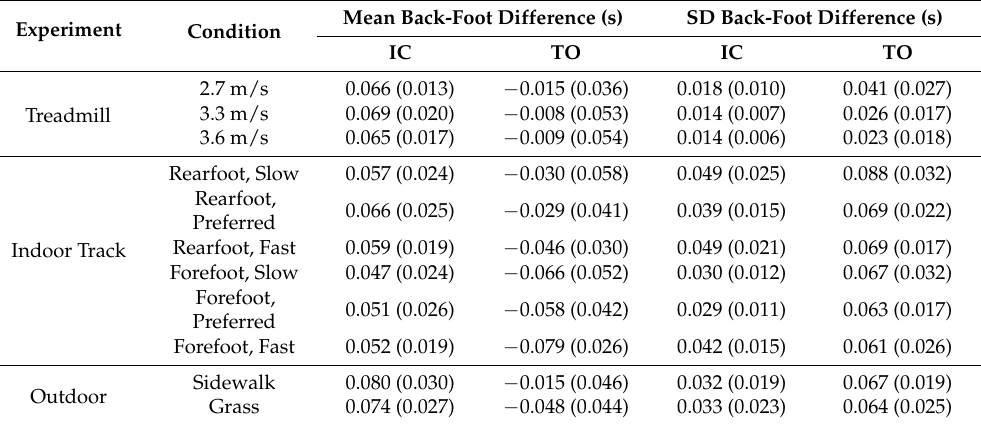
Table 1. The mean and standard deviation (SD) of the back-foot difference in all running conditions.